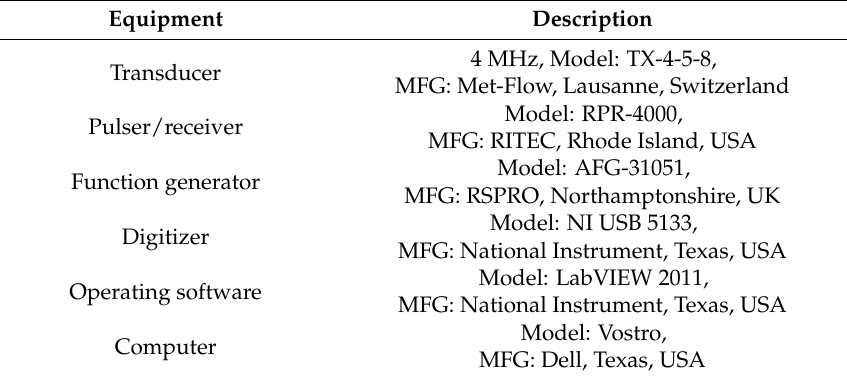
Table 3. Equipment list for the Ultrasonic Velocity Profiler (UVP) system.